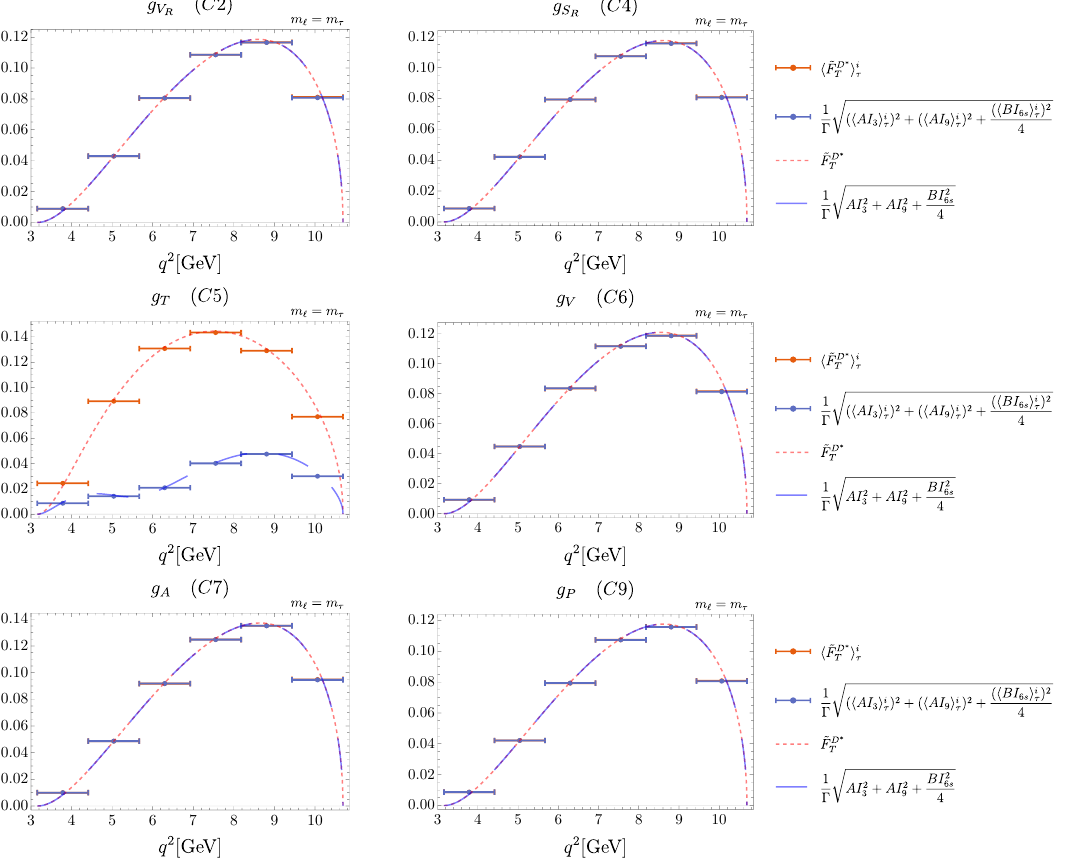
Figure 9. Study of binning e(cid:11)ects for eq. (4.17) for benchmark NP scenarios with complex con- tributions.